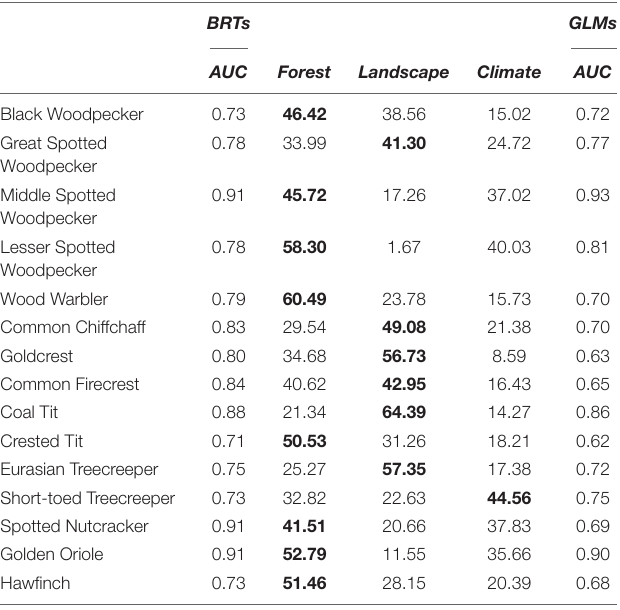
TABLE 5 | Summary table of the BRT model performances, respective contribution of forest, landscape and climate predictors, and GLM model